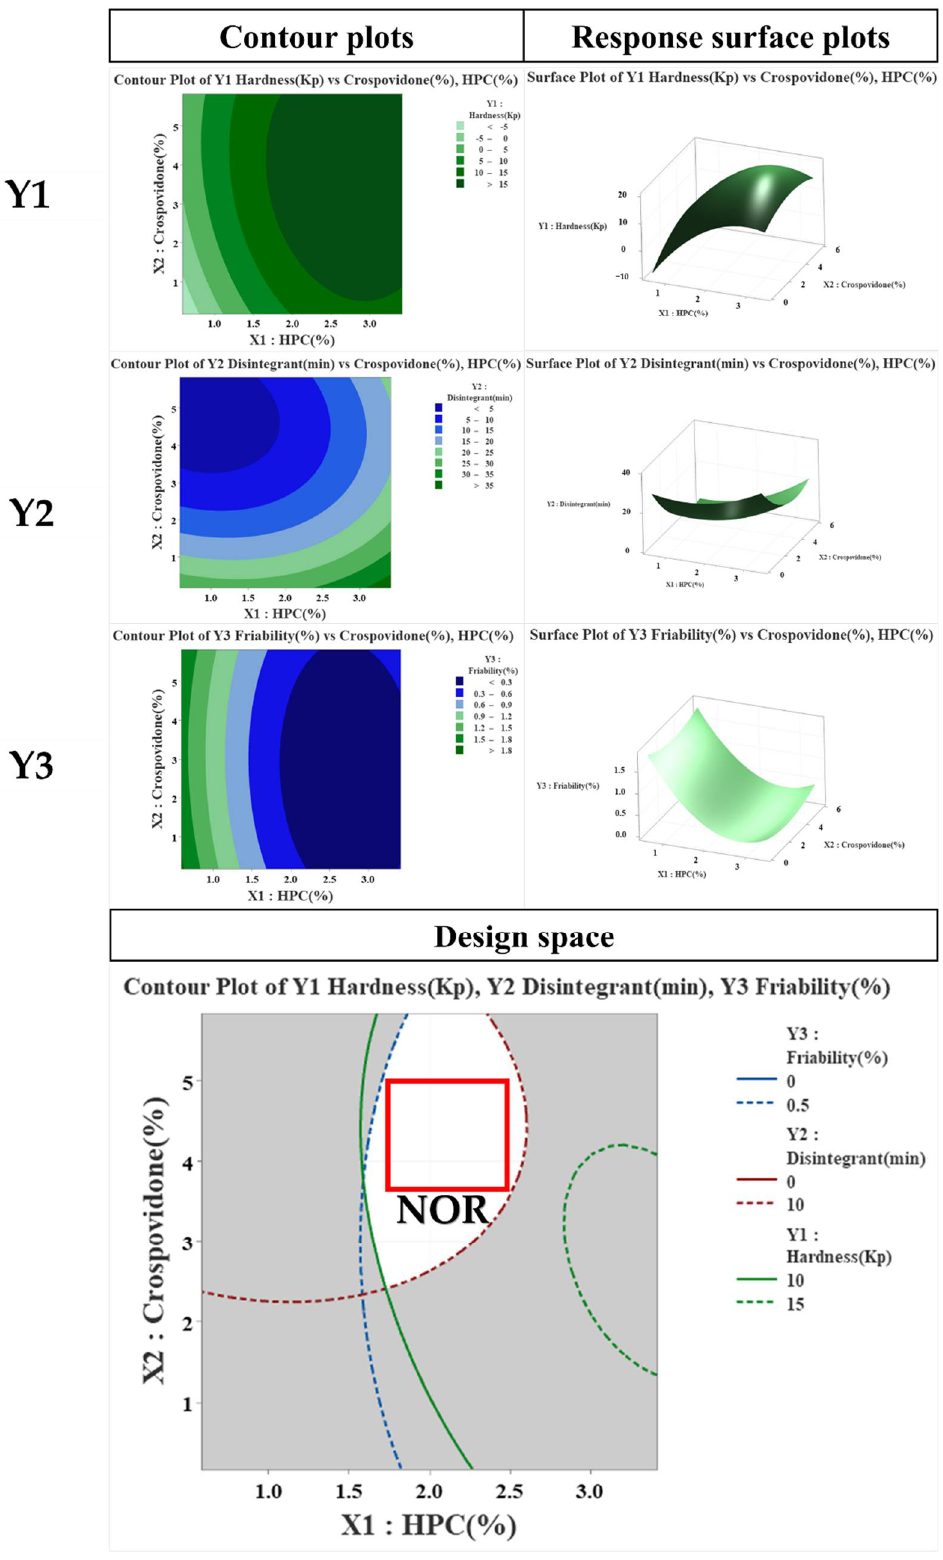
Figure 3. Effects of critical material attributes (CMAs) using contour plots, and response surface plots.